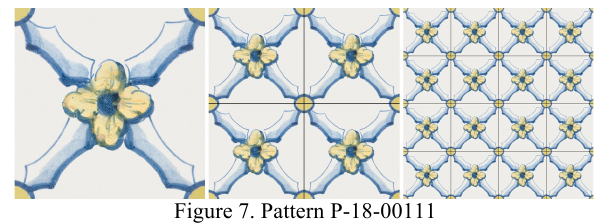
Figure 7. Pattern P-18-00111 Photo by Az Infinitum / Inês Aguiar